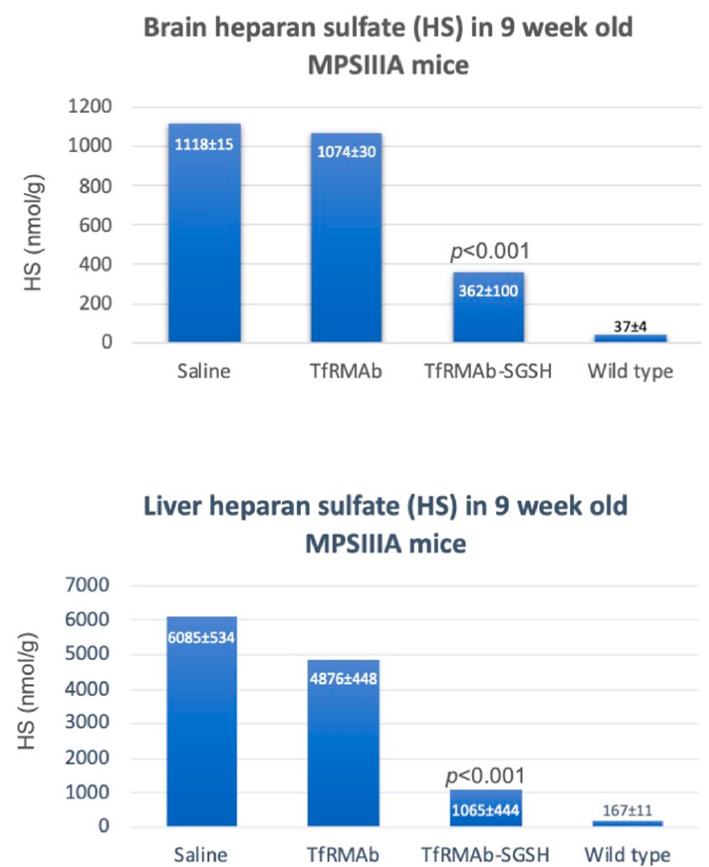
Figure 6. Reduction in brain heparan sulfate (HS) in the MPSIIIA mouse with systemic administration of a mouse TfRMAb-SGSH fusion protein. Two-week-old MPSIIIA mice (JAX) were treated three times per week for 6 weeks with IP 5 mg/kg of the TfRMAb-SGSH fusion protein or the isotype control (TfRMAb). The mice were euthanized 1 week after the last dose. HS was measured in brain and liver by LC-MS following enzymatic digestion into disaccharides using HS disaccharide standards. The 30-fold elevation in HS in the brain was reduced 70% by the chronic treatment with the IgG fusion protein ( top ). HS was also elevated in liver, and treatment with the mouse TfRMAb-SGSH reduced hepatic HS by 85% ( bottom ). Data are expressed as means ± SD ( n = 8 mice/group). From [37] with permission.